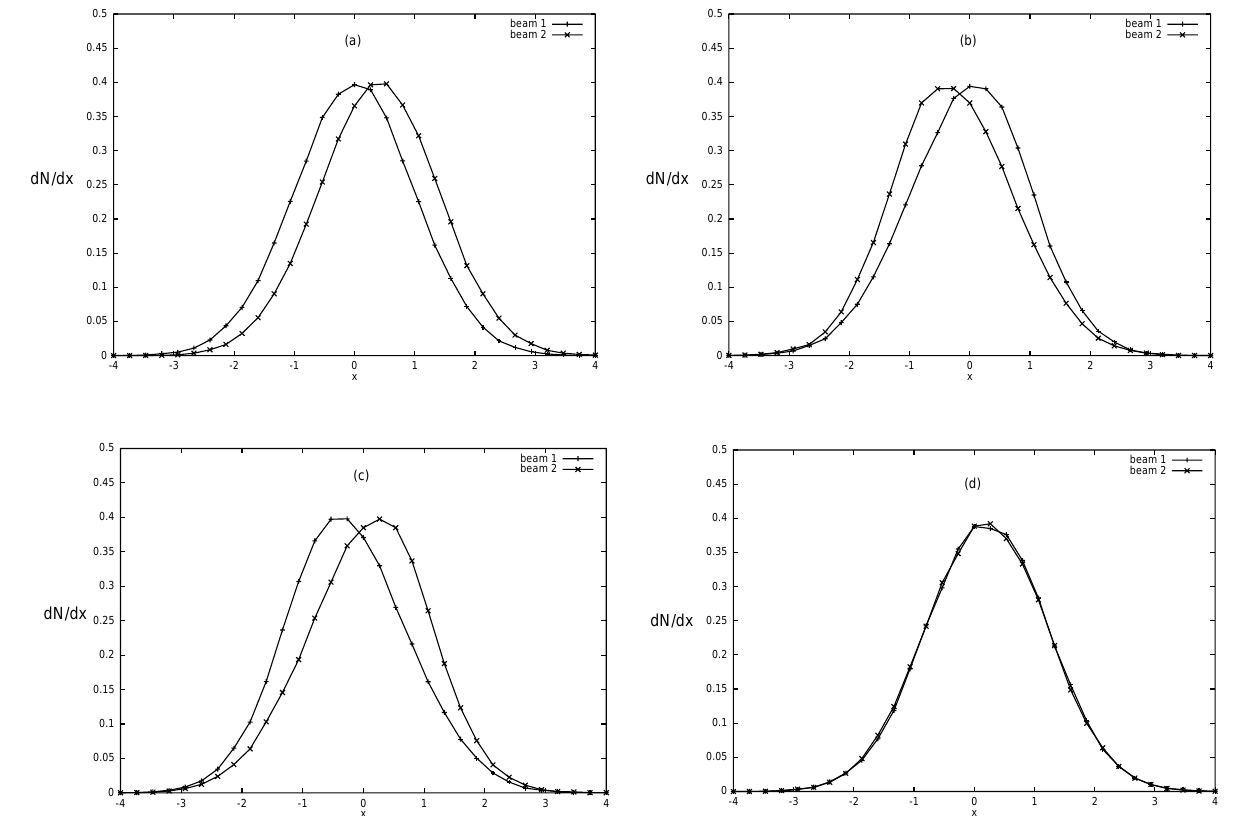
FIG. 3. Dynamics of the two strong beams ( N (cid:1) 10 5 macroparticles, Q (cid:1) 0.32 ) in a one-dimensional simulation for round beams. The horizontal axis is the normalized position x . The vertical axis shows the macroparticle distribution as obtained from the simulation. (a) Initial state, (b) after 2 17 2 2 turns, (c) after 2 17 2 1 turns, (d) after 2 17 turns. The core of the beam oscillates coherently and the tails do not